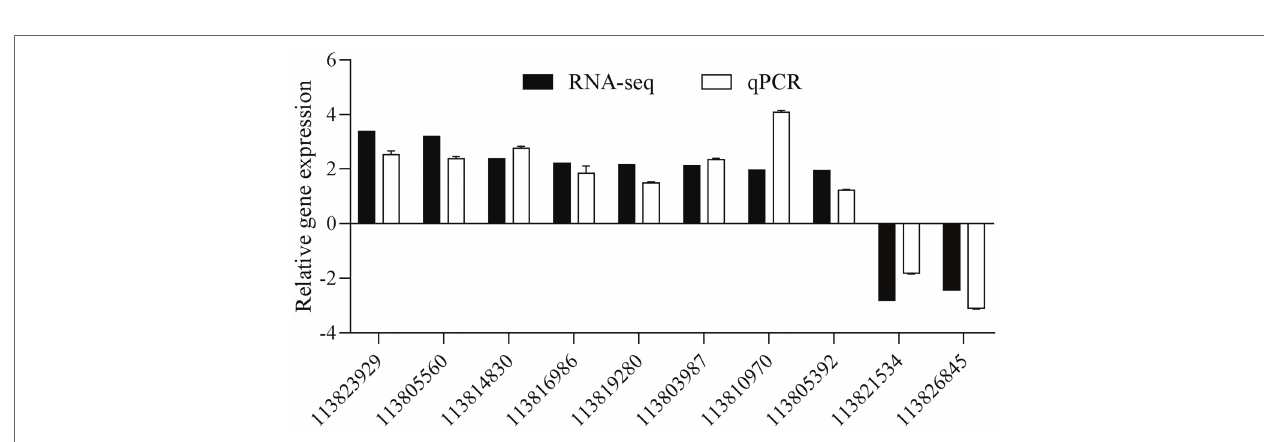
FIGURE 8 | Validation of DEGs by quantitative PCR (qPCR). The detection of gene expression was performed in triplicate for each sample. Expression values were normalizsed to those of LvEF1 α using the Livak (2 −ΔΔCt ) method, and the data were provided as the means ± SD of triplicate